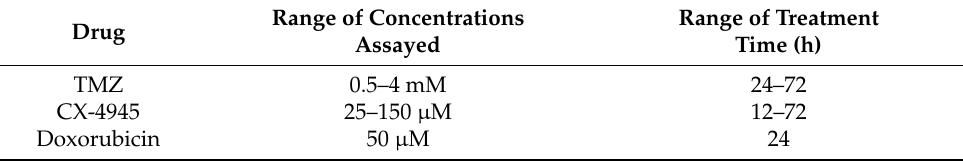
Table 1. Drug concentrations and treatment time ranges used in this